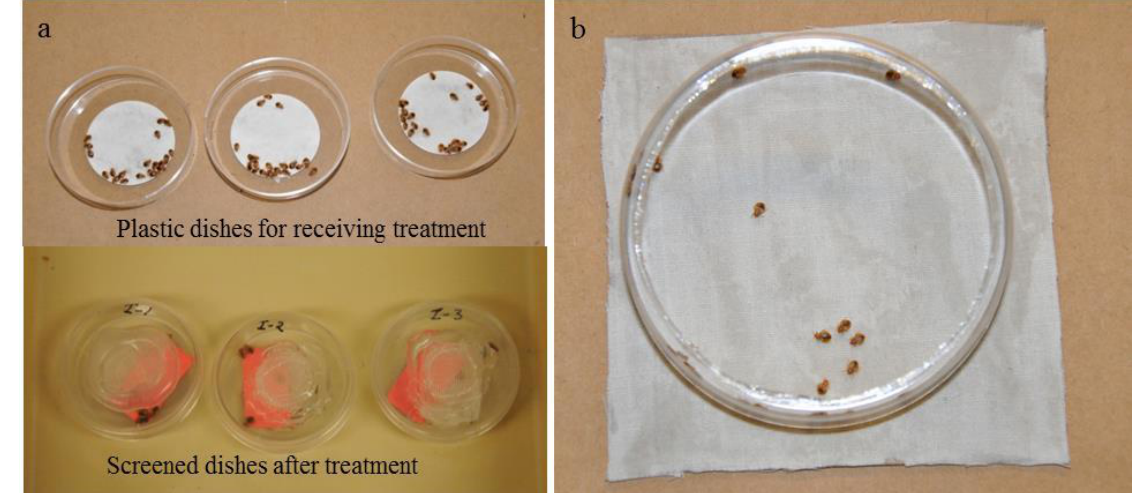
Figure 1. Experimental set up for evaluating the efficacy of Alpine aerosol: (a) Direct spray bioassay. (b) Dry residue exposure